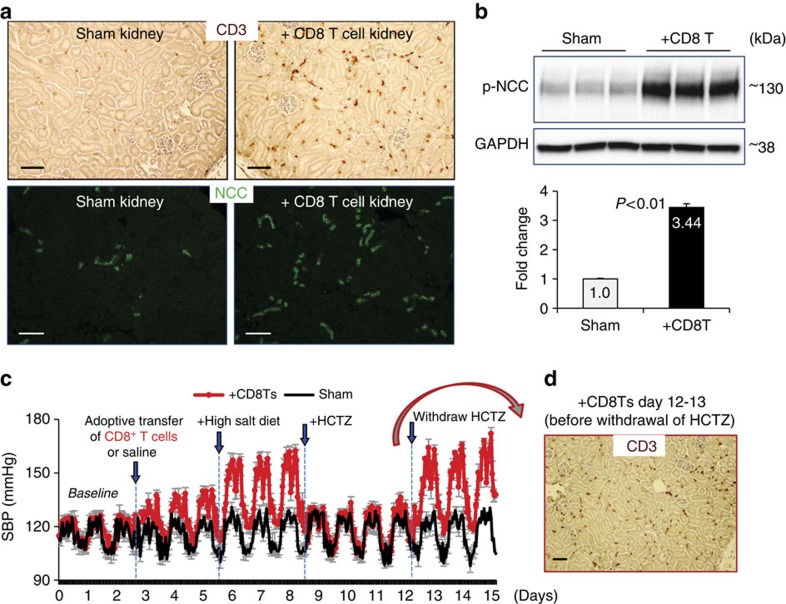
Adoptive transfer of CD8+ T cells to mice results in salt-sensitive hypertension.(a) Immunostaining of pan T cell marker CD3 (brown, upper level, scale 50 μm) or NCC (green, lower level, Scale, 100 μm) in kidneys from sham mice or mice receiving CD8+ T cell-adoptive transfer (+CD8 T cell). Data are representative of n=10 images in each group. (b) Western blot analysis of p-NCC expression in the kidneys of sham mice and mice receiving CD8+ T cell-adoptive transfer (+CD8 T). Quantitative western blot data were normalized using GAPDH as a loading control. n=5–6 in each group. Data are means±s.e. P<0.01 (t-test). (c) Averaged radio-biotelemetry recording of systolic blood pressure in 5 mice with saline injection (sham, black line) and 10 mice receiving adoptive transfer of CD8+ T cells (+CD8Ts, red line). All mice were given high-salt diet and HCTZ drinking water as indicated. Blood pressure was recorded hourly. Data are means±s.e. (d) At day 13 (last day of HCTZ treatment) 4 mice from +CD8 T group were removed from the blood pressure recording and their kidneys were used for immunostaining for CD3. Scale, 50 μm.